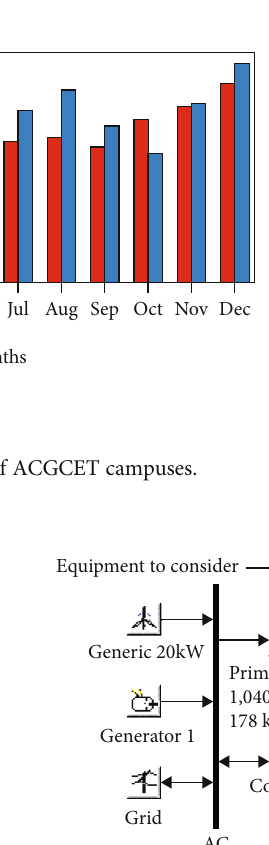
Figure 4: Average solar irradiation level of ACGCET campus.